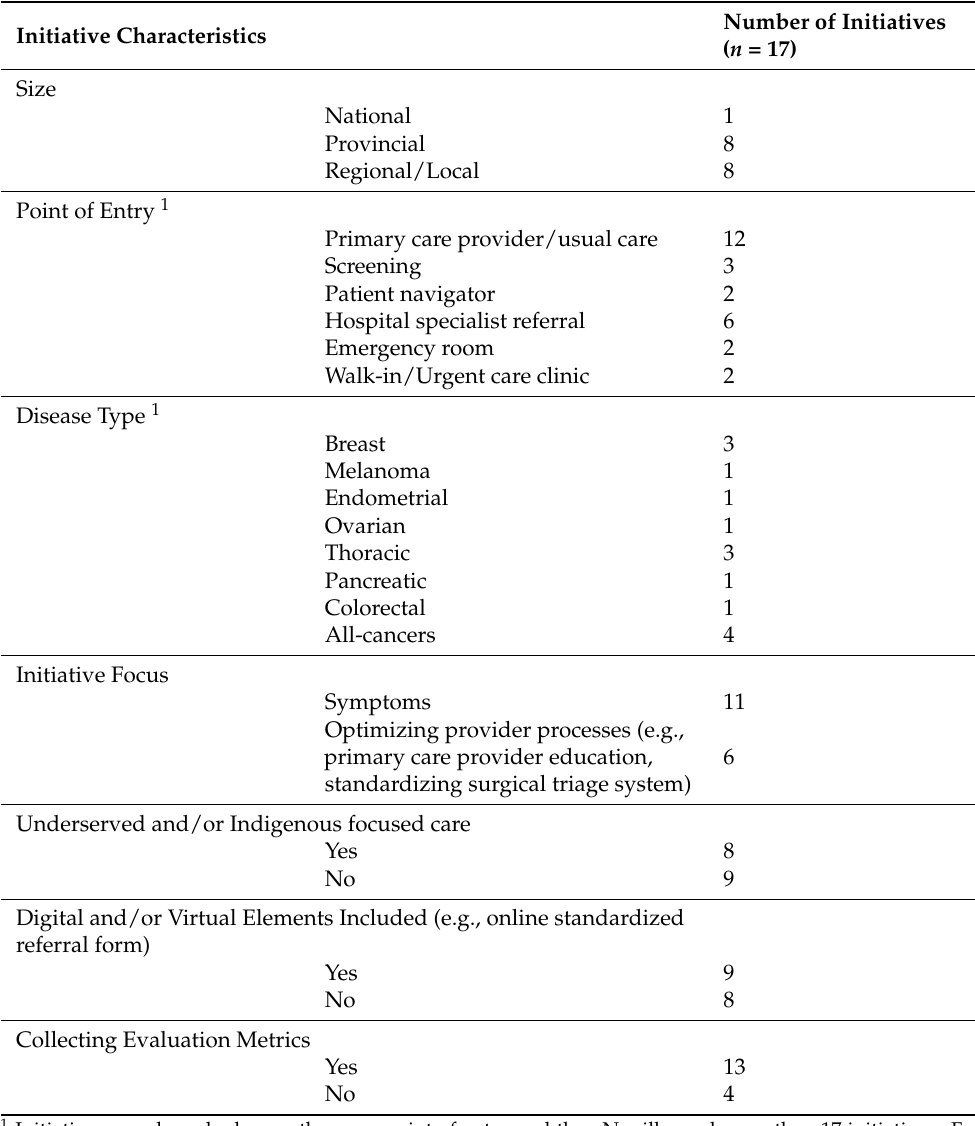
Table 1. Initiative